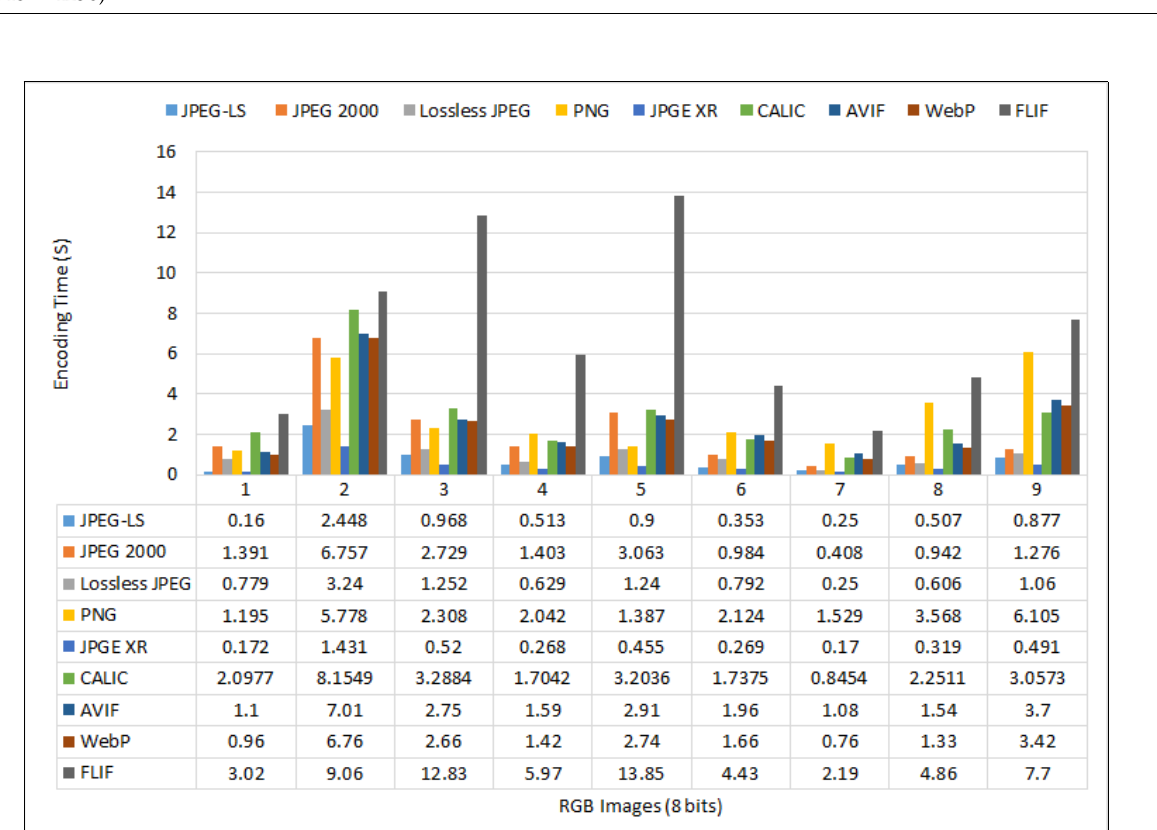
Figure 18. Comparison of encoding times for 8-bit RGB